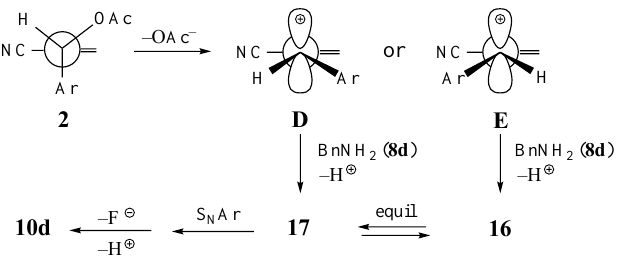
Scheme 2. Possible carbocation mechanism for the formation of dihydroquinoline 10d .